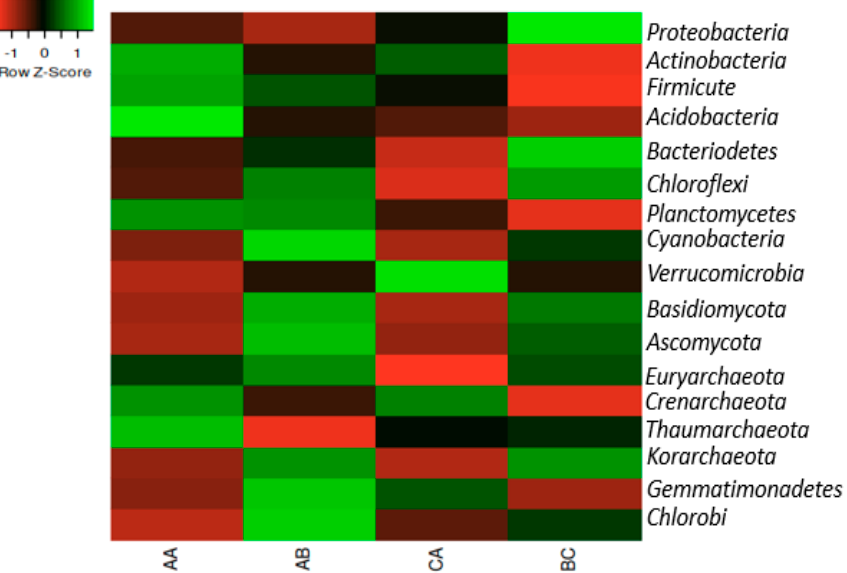
Figure 1. The heatmap representation of the relative abundances of the Phyla in the samples. The scale bar depicts a color saturation gradient based on relative abundances of the Phyla that have been z-score converted. AA, AB, and CA are rhizosphere soil samples while BC is a bulk soil